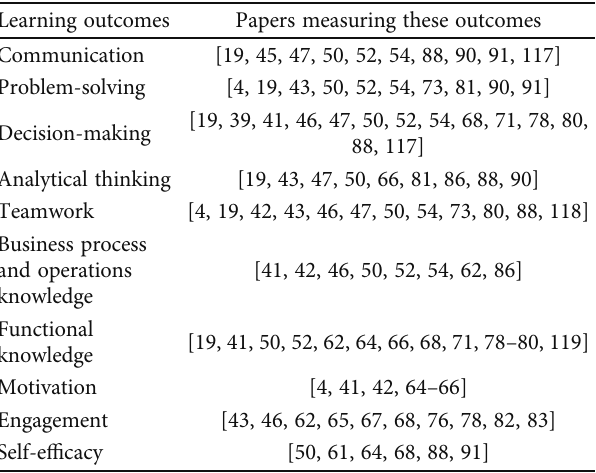
Table 7: Learning outcomes in selected studies. Learning